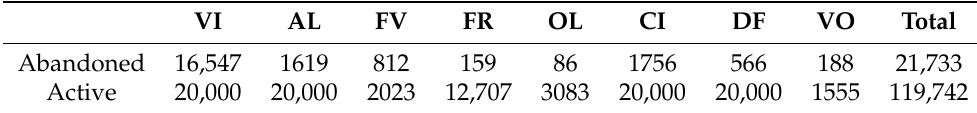
Table 1. Ground truth: number of pixels for every class.